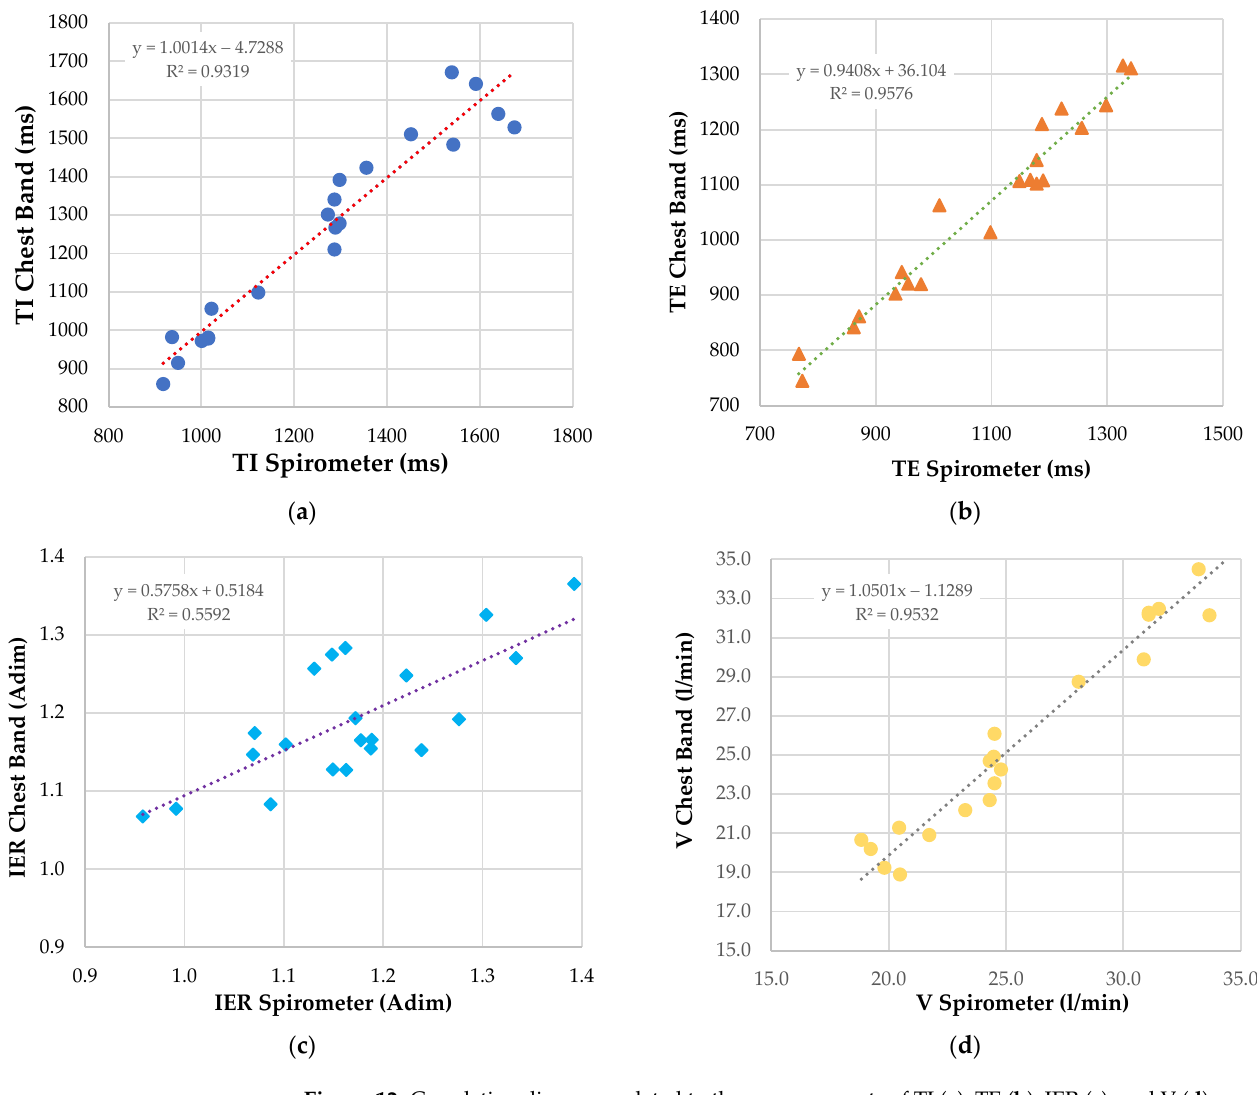
Figure 12. Correlation diagrams related to the measurements of TI ( a ), TE ( b ), IER ( c ), and V ( d ), carried out through the use of the developed chest band and the spirometer used as reference. The colored symbols (i.e., blue and yellow dots, orange triangles, and blue squares) indicate the data points.